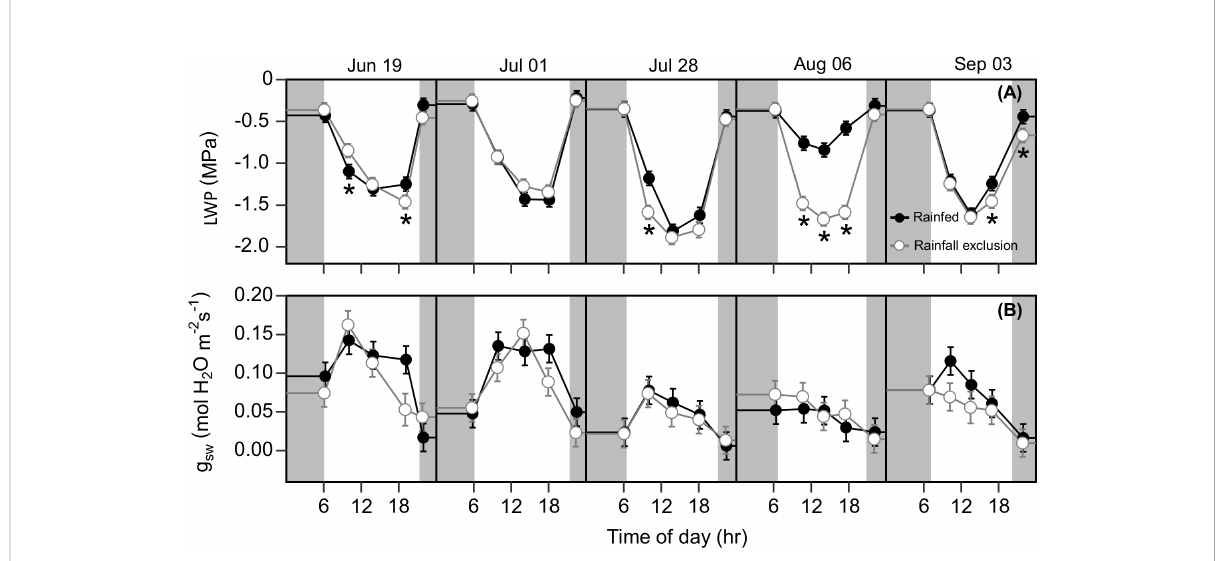
FIGURE 6 Switchgrass leaf water potential ( LWP ; (A) and stomatal conductance to water ( g sw ; (B) at each timepoint during the day, over the course of the growing season, for plants grown under (white fi ll, grey line) and outside (black fi ll, black line) rainfall exclusion shelters. Asterisks indicate a signi fi cant difference between treatments (P< 0.05). Data are mean ± S.E. (n = 4).